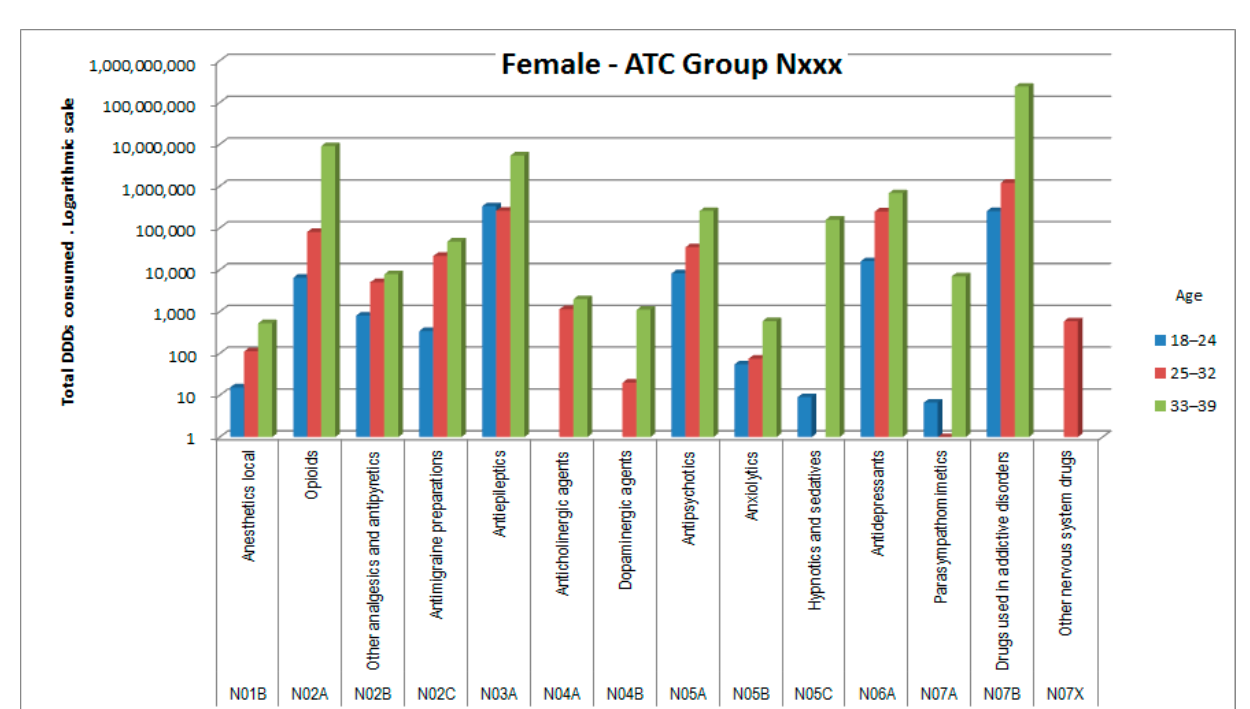
Figure 8. DDD consumption for females, ATC subgroup A11x (vitamins).